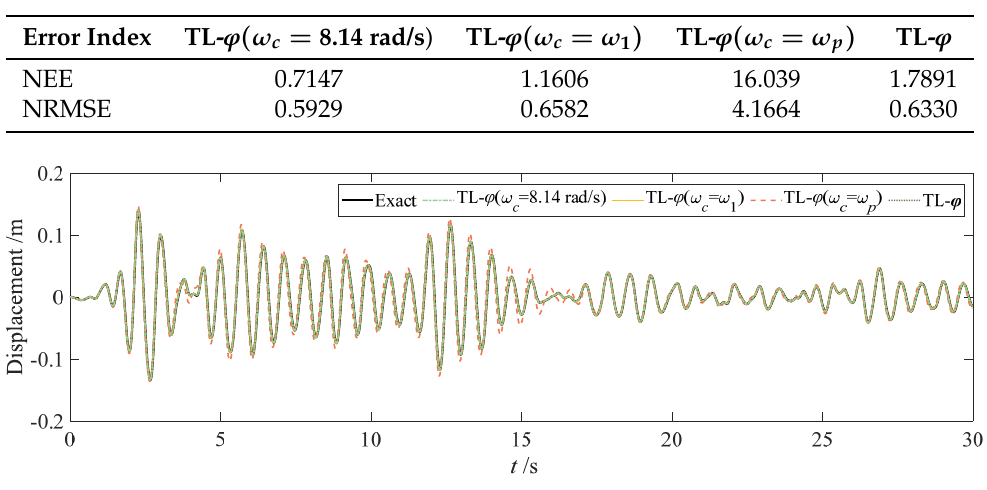
Figure 13. Displacement responses of the 4th story.